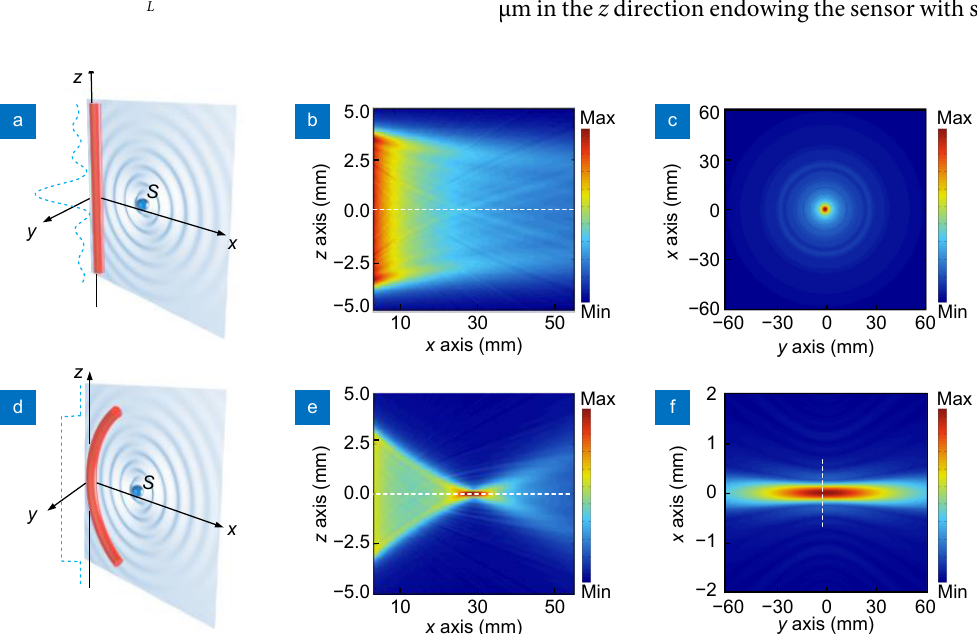
Fig. 2 | ( a, d ) Schematics of a straight sensor and curved (bending radius R =30 mm) sensor subjected to a point ultrasound source. The dashed curves show the acoustic phase variation along the fiber. ( b – c ) Calculated spatial sensitivities of a straight sensor in the x - z and x - y planes. ( e – f ) Calculated spatial sensitivities of a curved sensor in the x - z and y - z planes. Figure reproduced with permission from ref. 29 , Optical Society of